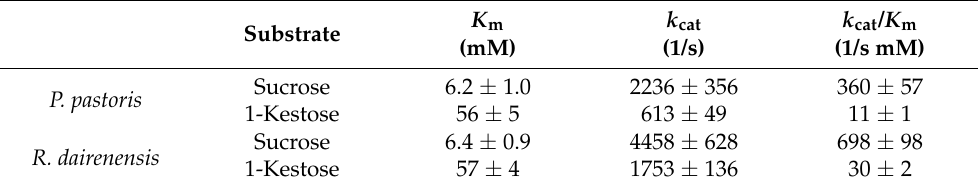
Table 2. Kinetic parameters of RdINV expressed in the indicated